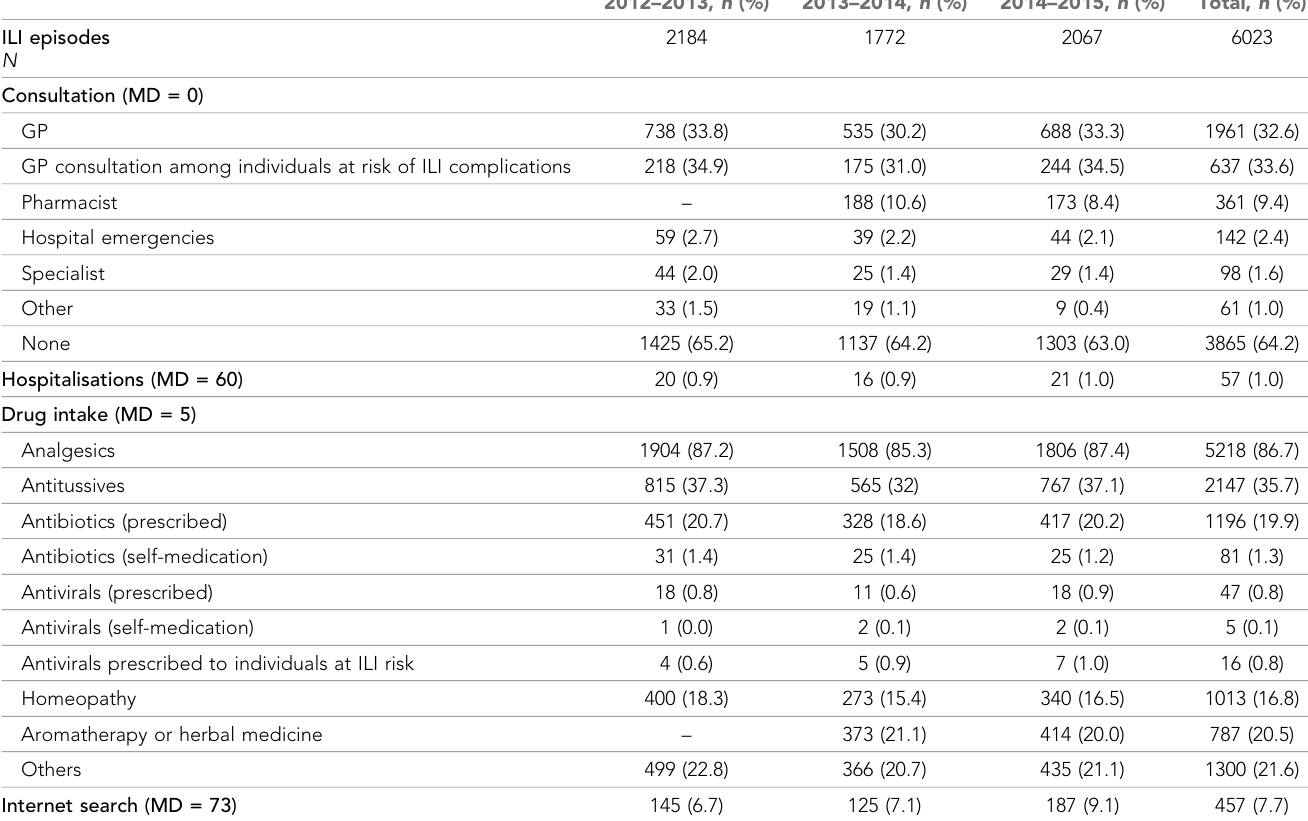
Table 4. Healthcare-seeking behaviour following ILI in participants included in the